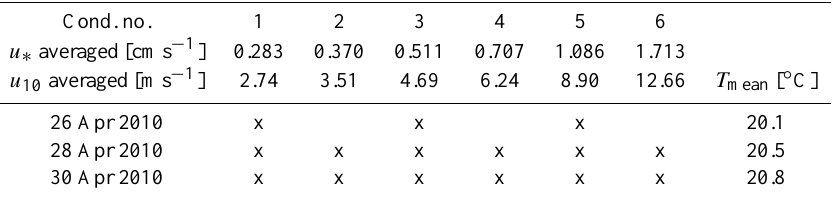
Table 1. Measurement conditions used in this study. Shown are the mean friction velocities u ∗ and the wind speeds u 10 averaged over the three measurement days, as well as the mean water temperatures for each day, T mean . The conditions at which measurements were conducted on each day are marked with an x. Cond. no. 1 2 0.283